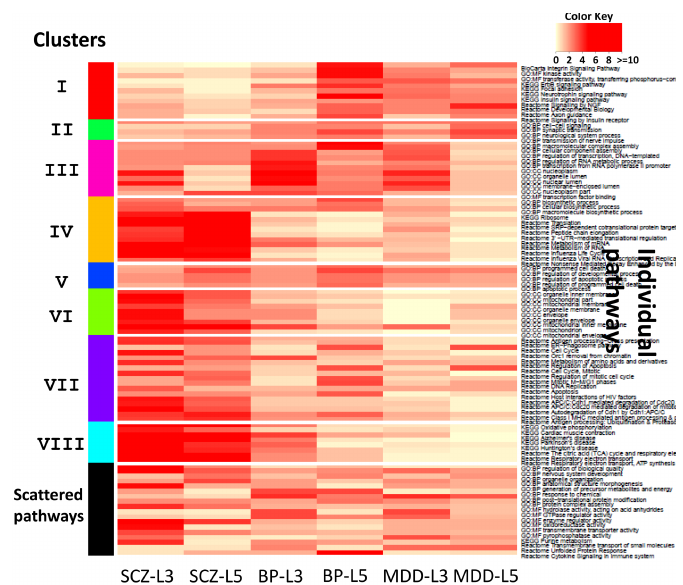
Figure 4. Heatmap of log10-scale pathway enrichment p -values of pathways annotated by eight pathway clusters (I-VIII) and a scattered pathway set